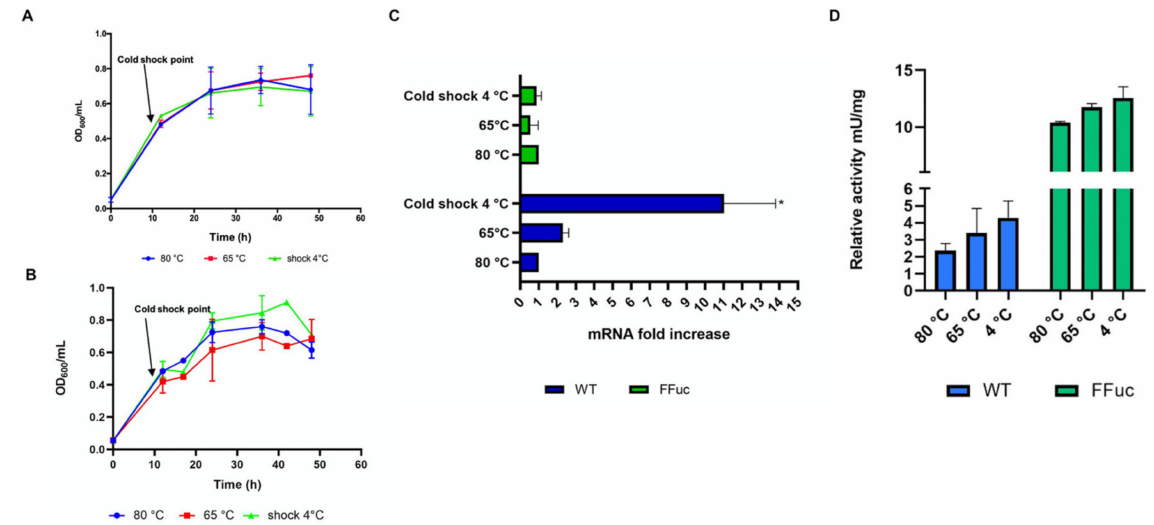
Figure 5. S. solfataricus strains response to cold-shock stress. ( A ) Growth curve of S. solfataricus WT strain at 80 ◦ C (blue) and subjected to cold shock at 65 and 4 ◦ C (red and green, respectively). Data are representative of three independent growth curves and are expressed as the mean ± SD. ( B ) Growth curve of S. Solfataricus FFuc strain at 80 ◦ C (blue) and subjected to cold shock at 65 and 4 ◦ C (red and green, respectively). ( C ) Real-time PCR of fucA and framefucA mRNA. The amount of mRNA in each strain grown at 80 ◦ C was set to 1 and the other values were normalized accordingly. Data are representative of three measurements and are expressed as the mean ± SD. Statistical significance was performed using the two-tailed paired Student’s t test (* p < 0.05) and ANOVA Dunnett’s test ( p < 0.0013). ( D ) Activity assays on WT and FFuc S. solfataricus cellular extracts on 4NP- α - L -fucopyranoside. Relative activity of α - L -fucosidase is expressed as